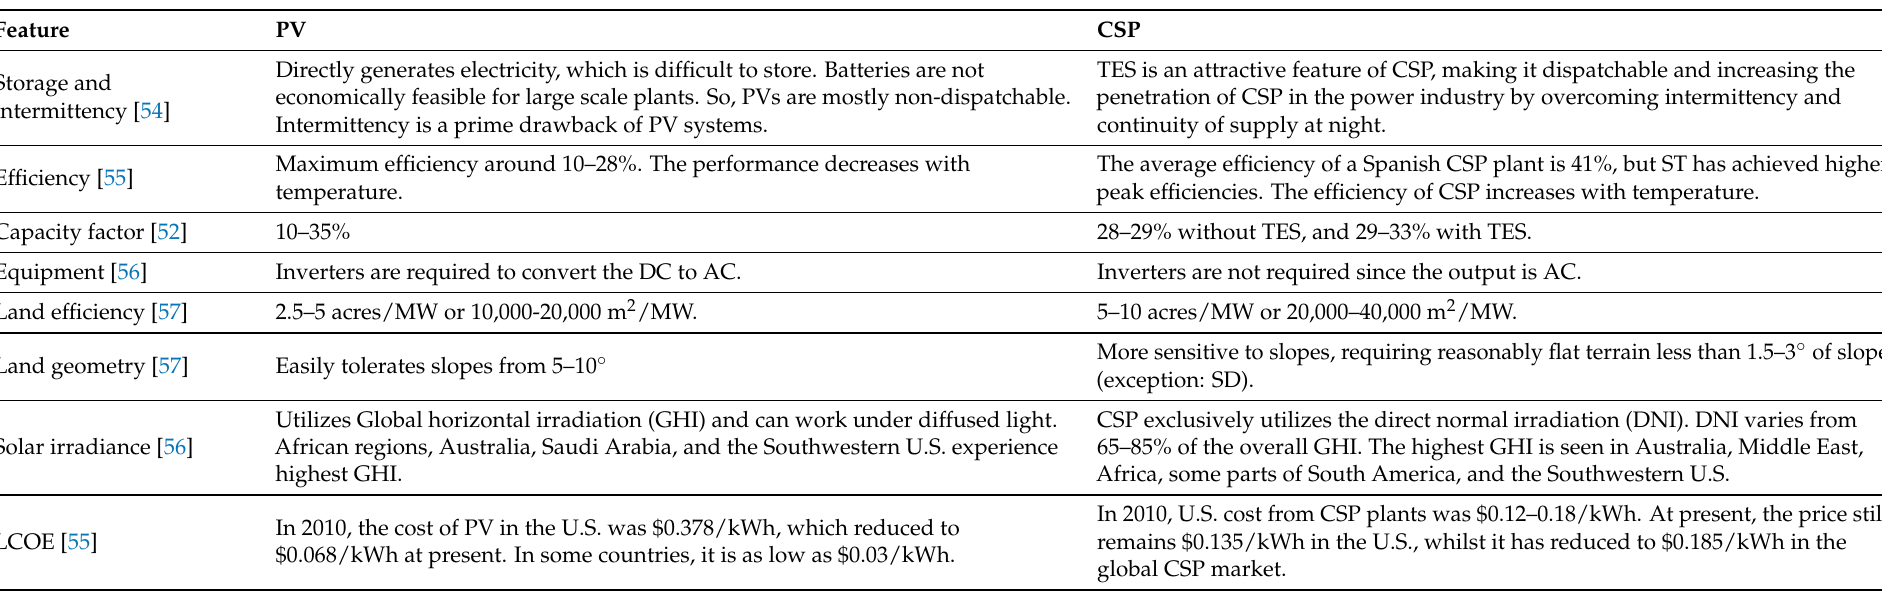
Table 2. Comparison between PV and CSP for utility-scale power